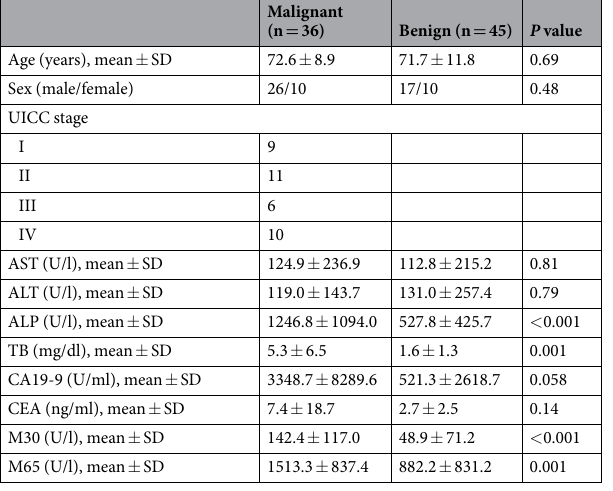
Table 1. Comparison of patient characteristics and markers. SD, standard deviation; ALP, alkaline phosphatase; TB, total